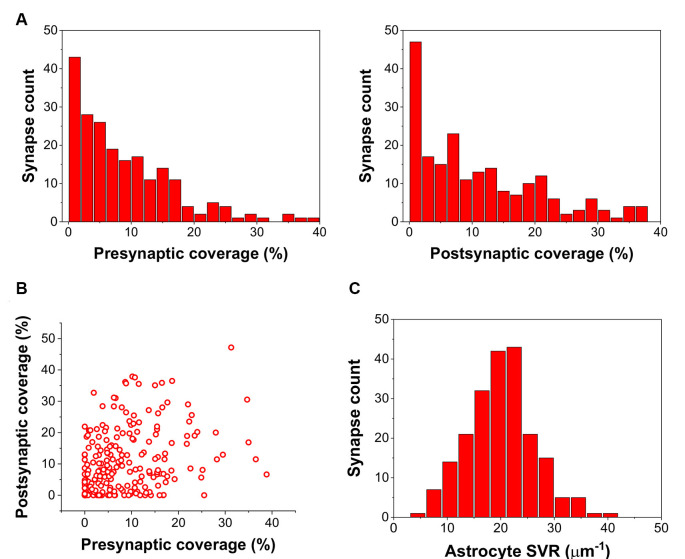
Astrocyte related geometric parameters of the 208 investigated synapses. (A) Distribution of pre-and postsynaptic coverage of synapses by astrocyte processes. (B) Correlation of pre-and postsynaptic coverage of synapses by astrocyte processes. (C) Distribution of the astrocytic surface/volume ratio (SVR) in the 1.2 × 1.2 × 1.2 μm volume surrounding each synapse.